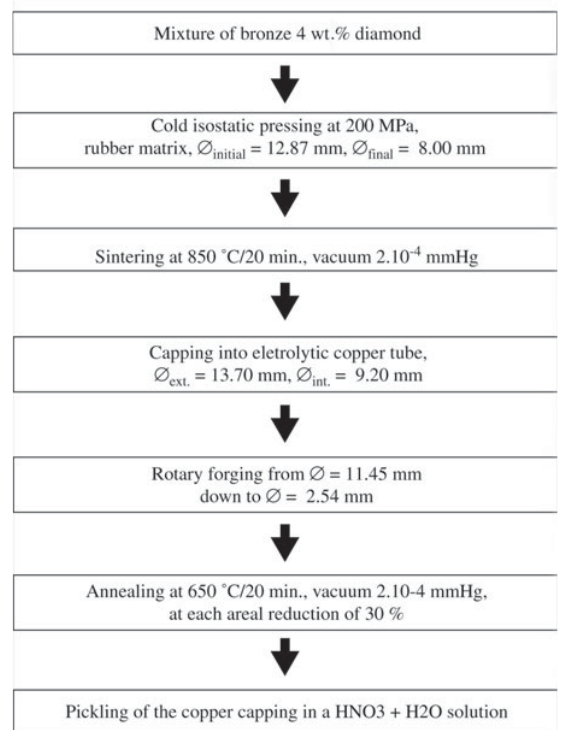
Figure 1. Processing flow chart of the bronze / diamond external cap.